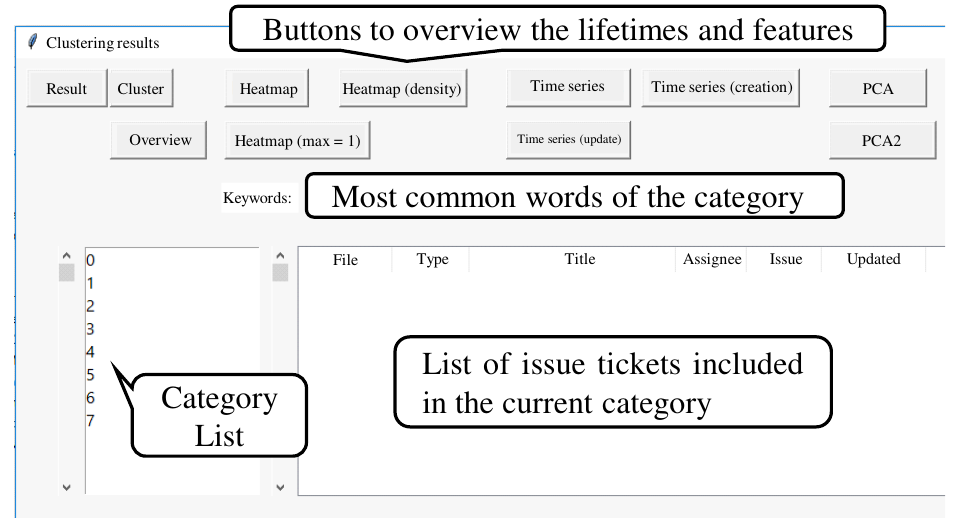
Figure 7. GUI of our